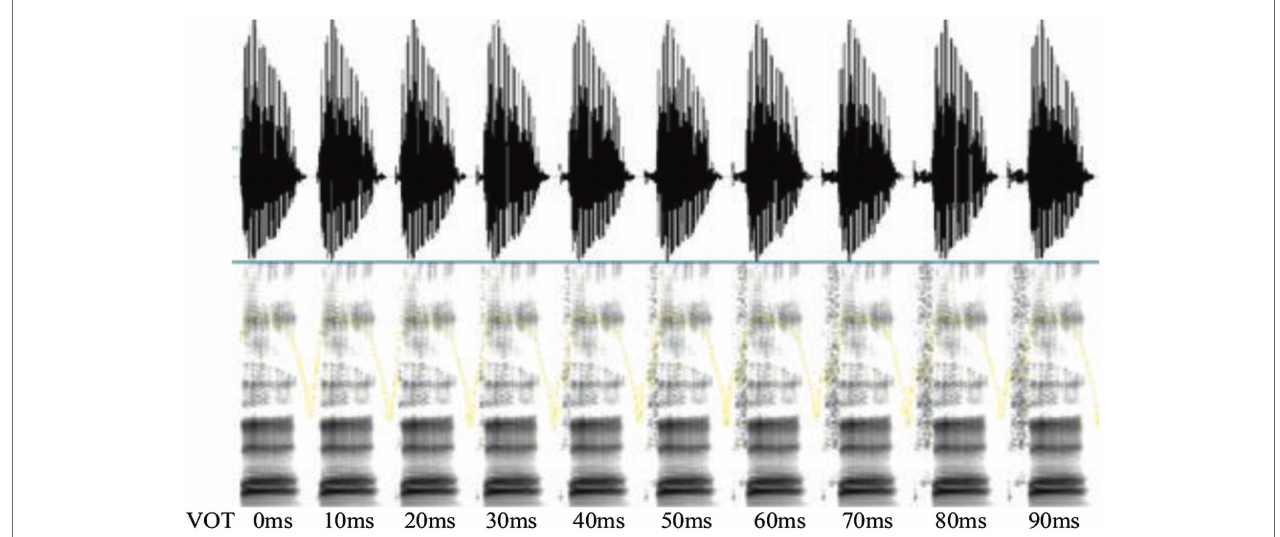
FIGURE 2 | The wideband spectrogram of the /pa1/ - /p h a1/